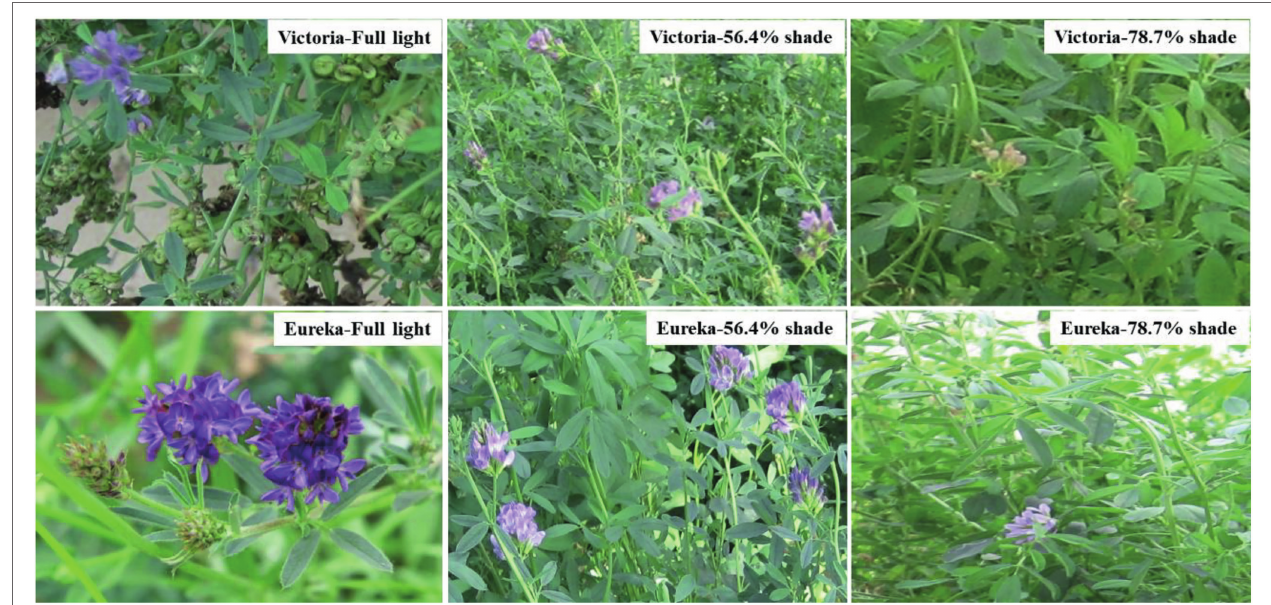
FIGURE 1 | Flower color of two alfalfa cultivars under different shading levels.